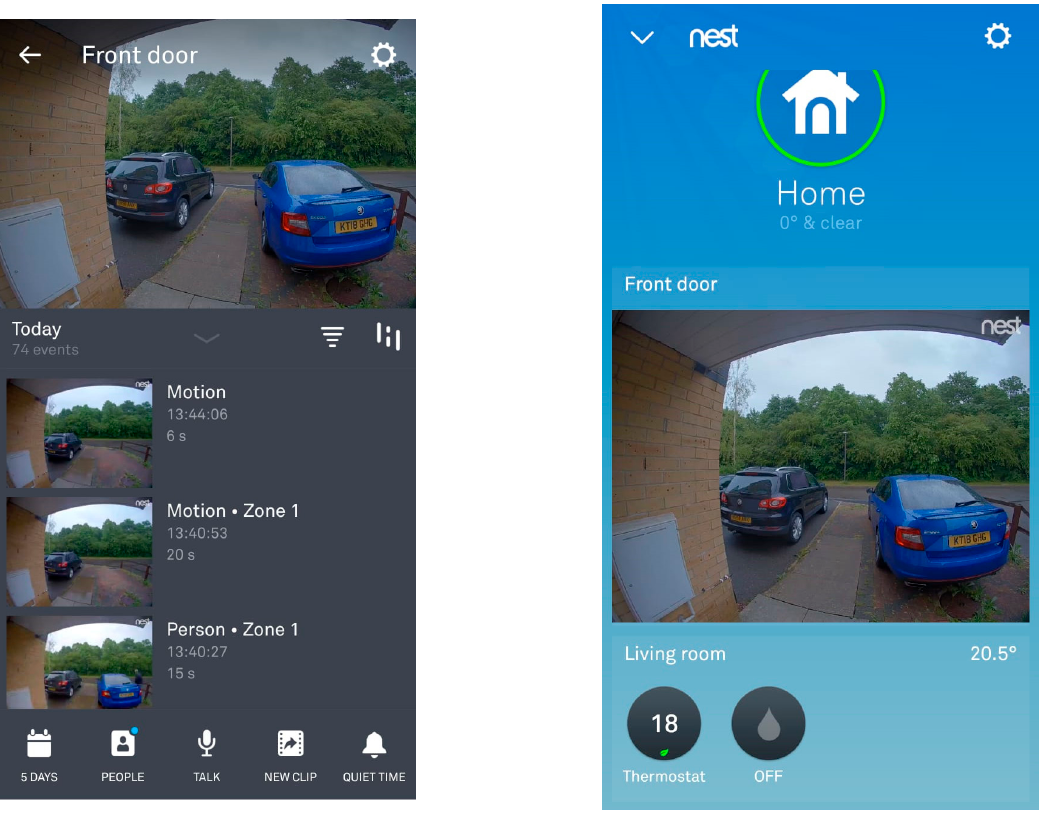
Figure 16. View of the camera from the user’s smartphone. This view can and is accessible whether you are at work, on holiday, in the home or out shopping. Permission granted and photograph taken by Leicester.